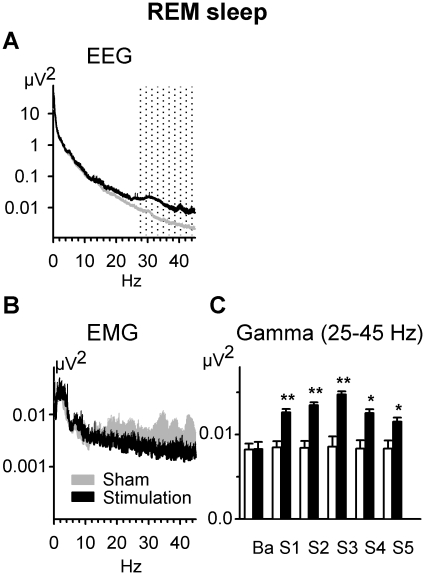
Changes in EEG spectral power induced by theta-tDCS during REM sleep.Spectral power for theta-tDCS (black lines) and sham stimulation (gray lines) averaged across all EEG locations (A) and for submental electromyographic (EMG) activity (B). Time course of gamma band activity during the five 1-min stimulation-free periods immediately succeeding the stimulation intervals (S1–S5), averaged across all electrode sites for theta-tDCS (black bars) and sham stimulation (empty bars) (C). ‘Ba’ refers to baseline activity prior to stimulation. **, P<0.01; *, P<0.05; for comparisons between the theta-tDCS and sham stimulation conditions by t-test (n = 16).